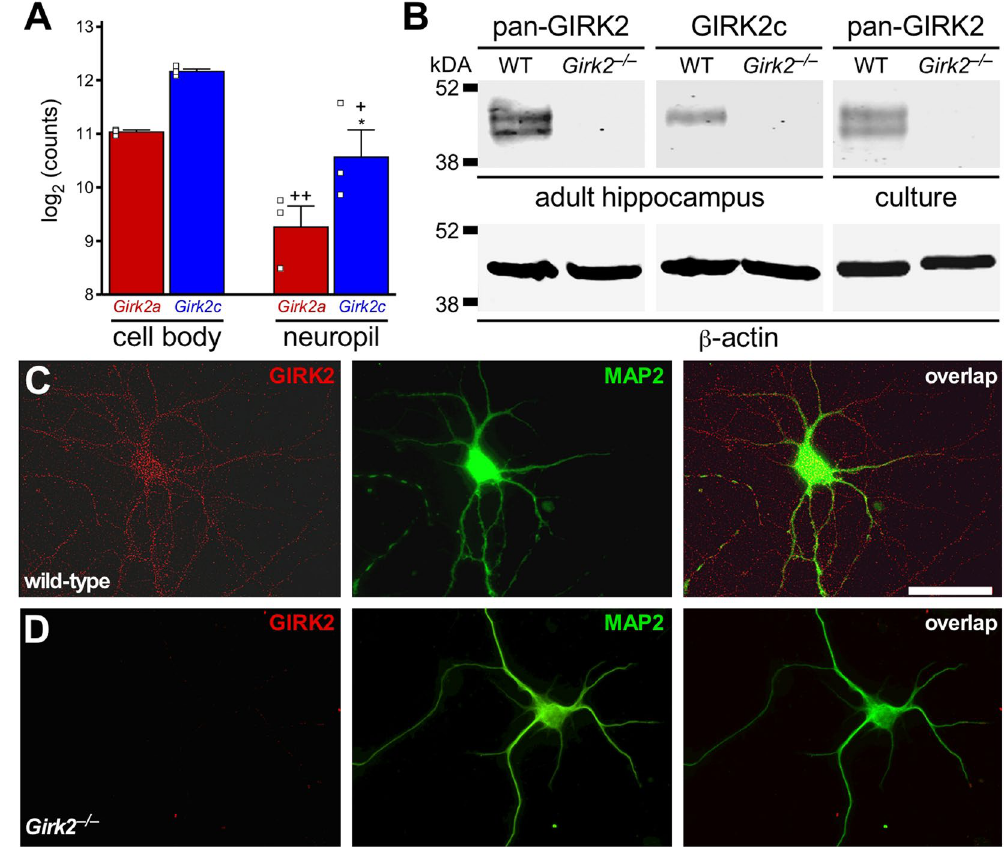
Figure 2. GIRK2 expression in the mouse hippocampus. ( A ) Girk2a and Girk2c mRNA levels as assessed by RNA-Seq in CA1 cell body and neuropil samples, taken from 3 adult mice. Main effects of isoform (F 1,8 = 14.3, P < 0.01) and compartment (F 1,8 = 27.1, P < 0.001) were observed, but there was no interaction between isoform and compartment (F 1,8 = 0.07, P = 0.80). Symbols: * P < 0.05 vs. GIRK2a (within compartment); + , ++ P < 0.05 and 0.01, respectively, vs. cell body (within isoform). ( B ) Representative GIRK2 immunoblots (from 3 independent experiments) of adult hippocampus and neonatal hippocampal culture (10–12 DIV) from wild- type (WT) and Girk2 − / − mice, probed with pan-GIRK2 or GIRK2c antibodies (upper blots), as well as a β -actin antibody (lower blots). ( C,D ) Representative images showing GIRK2 immunolabeling (as revealed with the pan-GIRK2 antibody) in cultured hippocampal neurons from wild-type ( C ) and Girk2 − / − ( D ) mice. Neurons were co-stained with a MAP2 antibody to highlight neuronal morphology and dendritic processes. Scale bar: 50